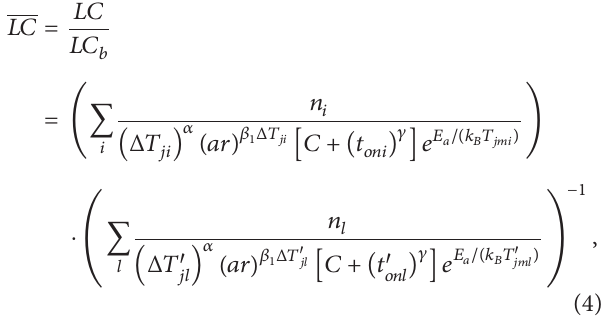
extracted under specific conditions (e.g., 0.07 s ≤ 𝑡 𝑜𝑛 ≤ 63 s) for the power switching devices introduced in